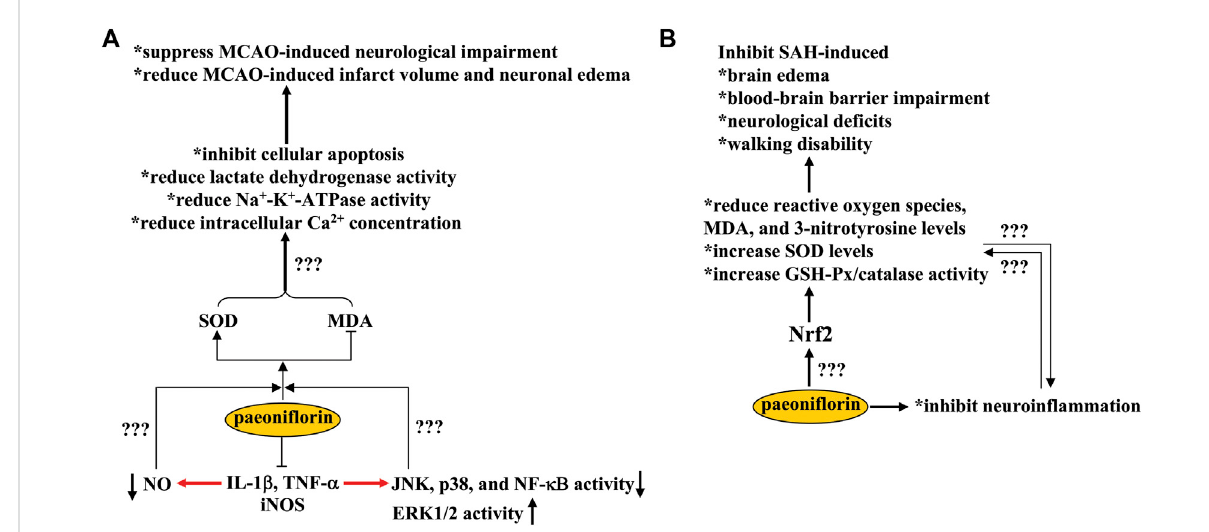
FIGURE 2 Effectsandmechanismsofpaeoni fl orinincerebralischemiaandsubarachnoidhemorrhage. (A) Paeoni fl orinadministrationsuppressesMCAO- induced neurological impairment and reduces MCAO-induced infarct volume and neuronal edema through mechanisms dependent on SOD elevation and MDA decrease, including inhibition of cellular apoptosis, lactate dehydrogenase/Na + -K + -ATPase activity, and intracellular Ca 2+ concentrationsinthebrain.Paeoni fl orincanalsosuppresstheproductionofpro-in fl ammatorymediatorsinthebrain,suchasIL-1 β ,TNF- α ,and iNOS, which subsequently leads to a decrease in NO production, a decrease in JNK, p38, and NF- κ B activity, and an increase in ERK1/2 activity. However, it remains unclear whether the neuroprotective effects of paeoni fl orin could be mediated by these processes. (B) Paeoni fl orin administration may suppress SAH-induced brain edema, blood-brain barrier impairments, neurological de fi cits, and walking disability by reducing reactive oxygen species, MDA, and 3-nitrotyrosine levels and increasing SOD levels and GSH-Px/catalase activities in the brain in a manner that